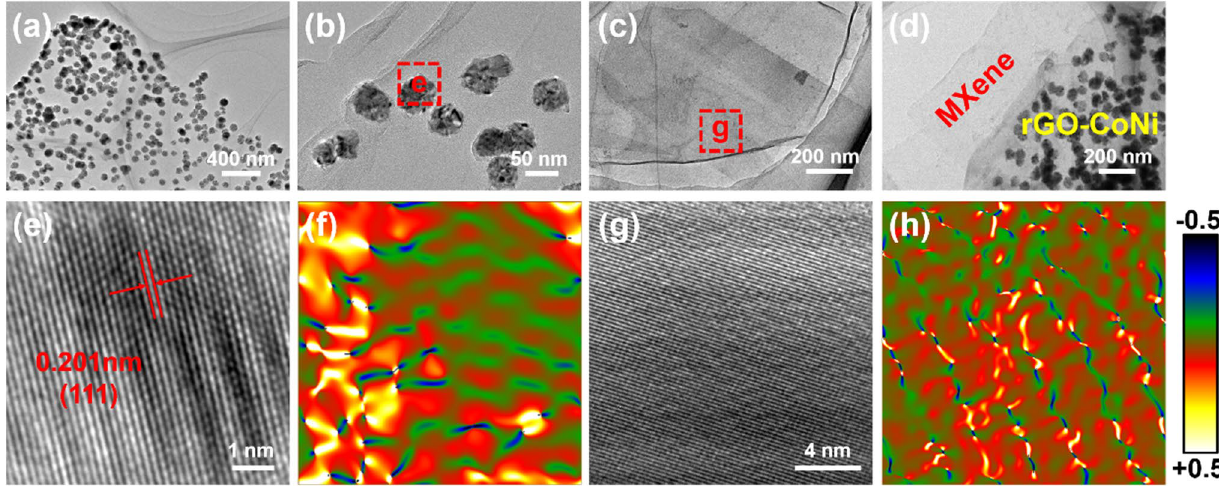
Fig. 4 TEM images of a , b rGO/CoNi, c MXene and d MXene- rGO/CoNi; HRTEM images of e CoNi in the rGO and f corresponding strain maps; HRTEM images of g MXene and h corresponding strain